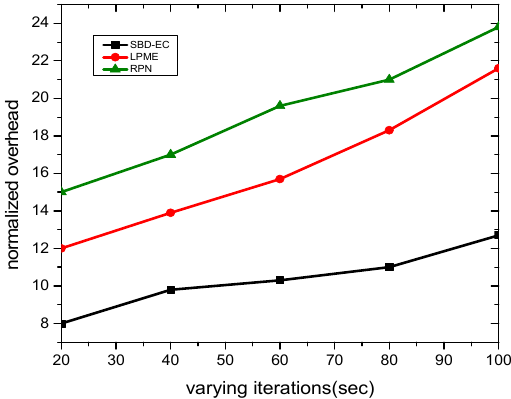
Figure 7. Normalized overhead and iterations.